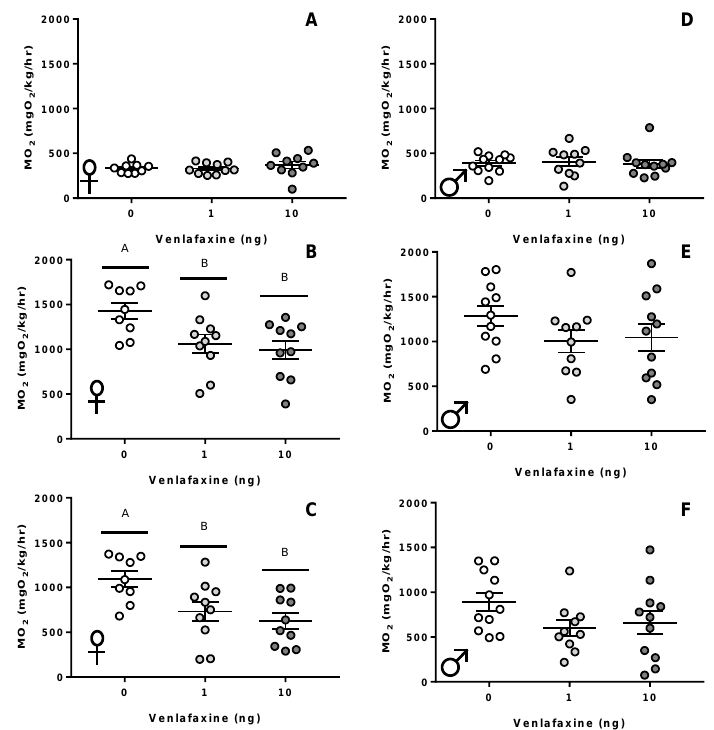
Figure 2. Metabolic rate. ( A , D ) Resting metabolic rate, ( B , E ) active metabolic rate, ( C , F ) the aerobic scope of 10–12 month old female ( A – C ) and male ( D – F ) zebrafish exposed to either 0, 1, or 10 ng venlafaxine at the 1–4 cell stage ( n = 10–15 for respiration measurements). Different letters denote significant differences between groups. Individual data points and mean are shown for each graph (±S.E.M).